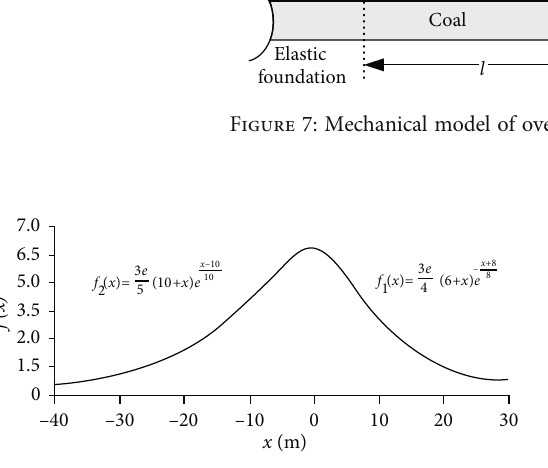
Figure 8: Support pressure curve of the top plate in front of the coal wall.